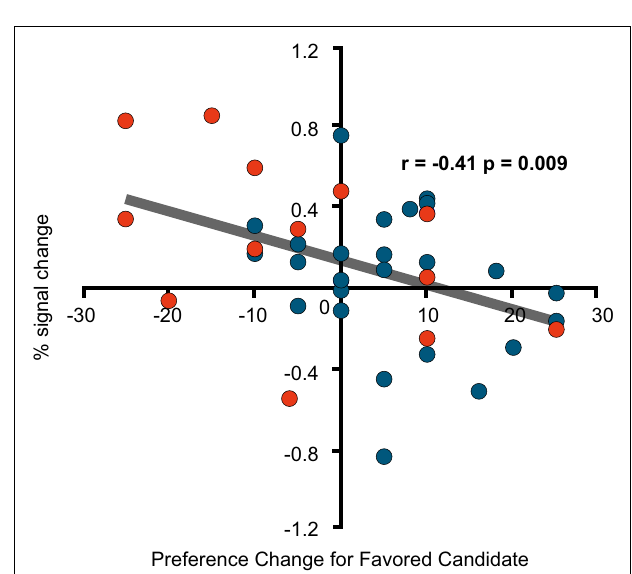
FIGURE 8 | fMRI signal change at the right dorsolateral prefrontal cortex. Correlation between the signal change at (51, 41, 11; BA46) during the second, positive advertisements and the preference change for the favoured candidate during the second, positive advertisements [=the post-session rating of the (originally) favoured candidate − the pre-session rating of the favoured